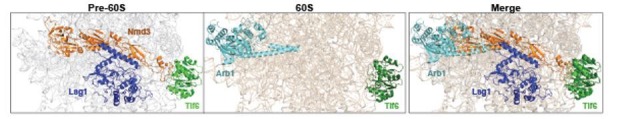
Arb1 location on a mature 60S clashes with Nmd3 binding site on a pre-60S.Cryo-EM structures of Nmd3-containing (PDB-6RZZ, Kargas et al., 2019) pre-60S and Arb1-containing (PDB-6R84, Su et al., 2019) mature 60S subunit were superimposed. Surprisingly, Arb1 binds to a region of rRNA, which overlaps with the binding site of Nmd3 on the pre-60S. We speculate that Nmd3 release allows Arb1 recruitment to the pre-60S during final cytoplasmic maturation.